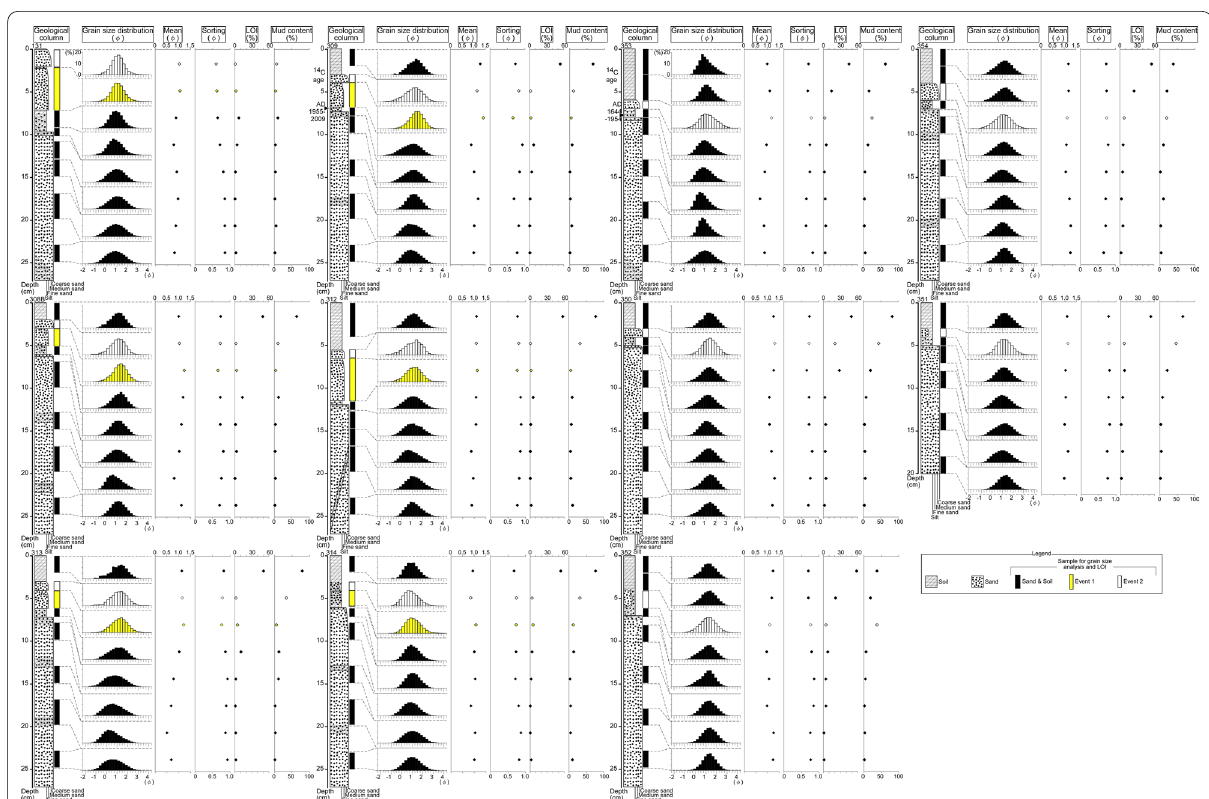
Fig. 4 Grain size and loss on ignition (LOI) analytical results for samples collected along transects a–b and